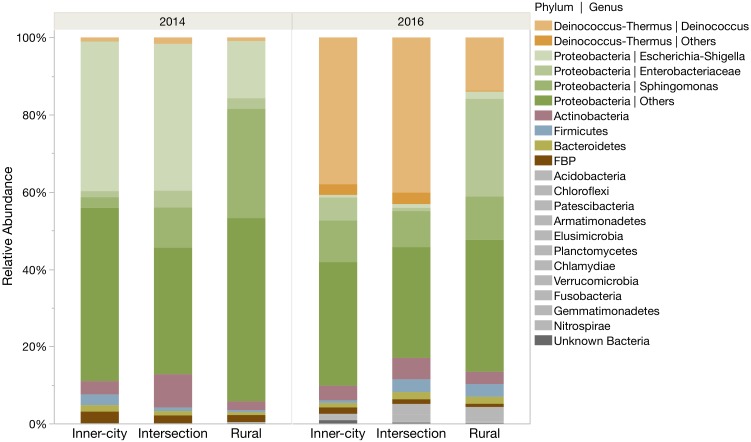
Relative abundance of ASVs for each location in both sampling years. ASVs are grouped into phyla and several prominent genera are highlighted within their phylum. The six most abundant phyla are color coded and the remaining twelve rare phyla are grouped as gray bars at the bottom.